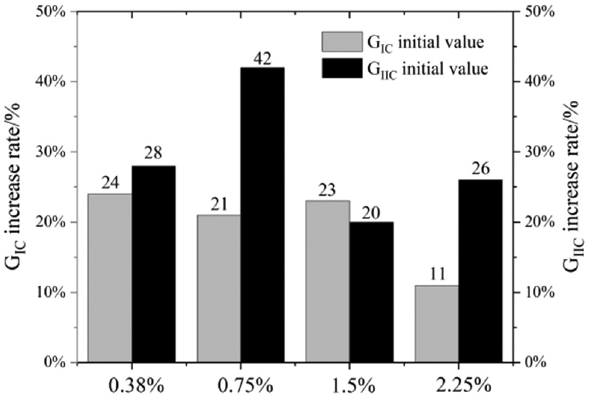
Figure 17: The SEM image shows that the MWCNTs in the sample containing 1.5 wt% COOH - MWCNTs are distributed in the epoxy resin matrix [ 90 ]